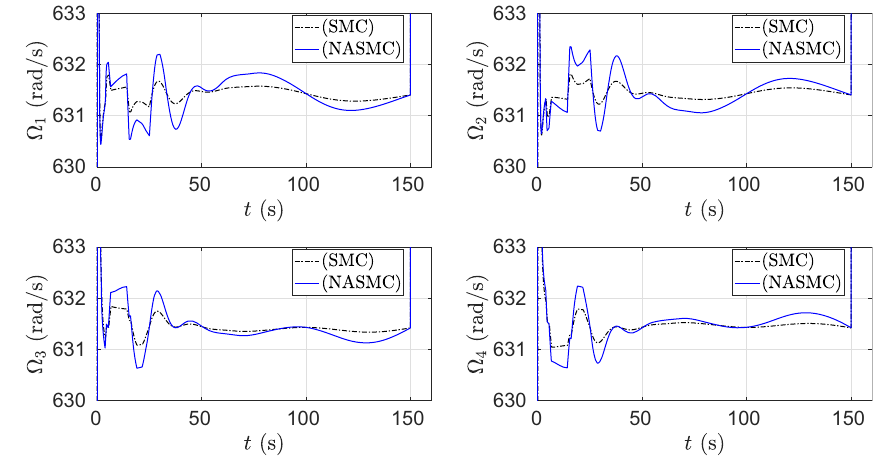
Figure 8: Rotor angular speeds of the quadcopter system using SMC and NASMC ( the fi rst 150 s of simulation ) .